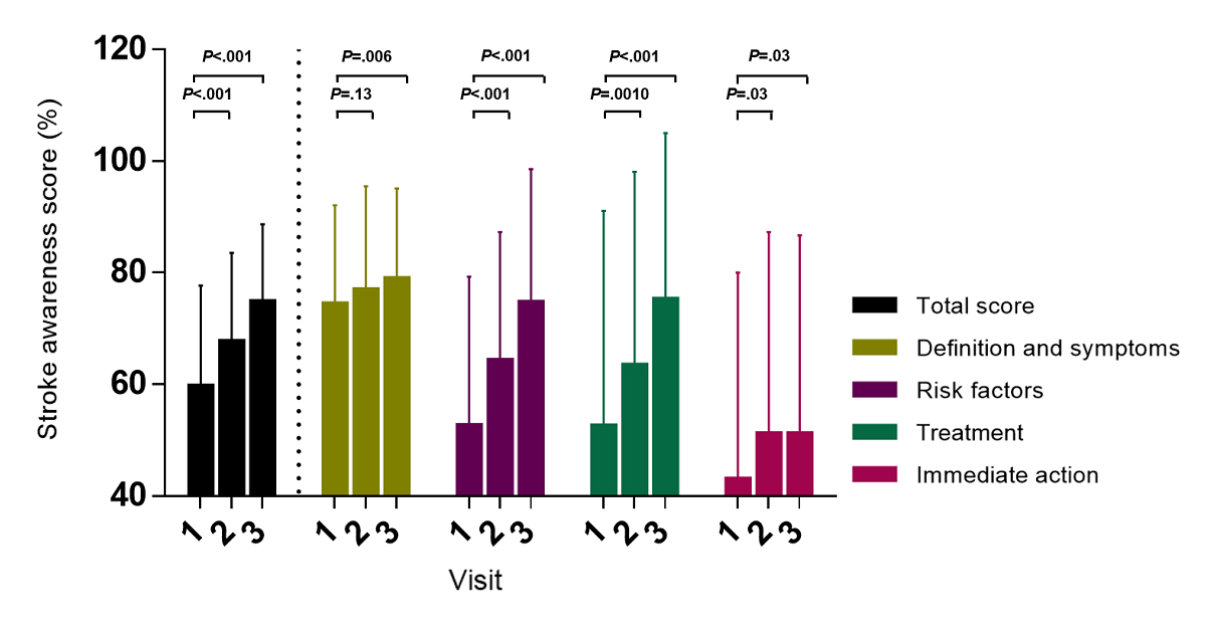
Figure 5. Trends in the stroke awareness score and its four components using the smartphone-based management system.